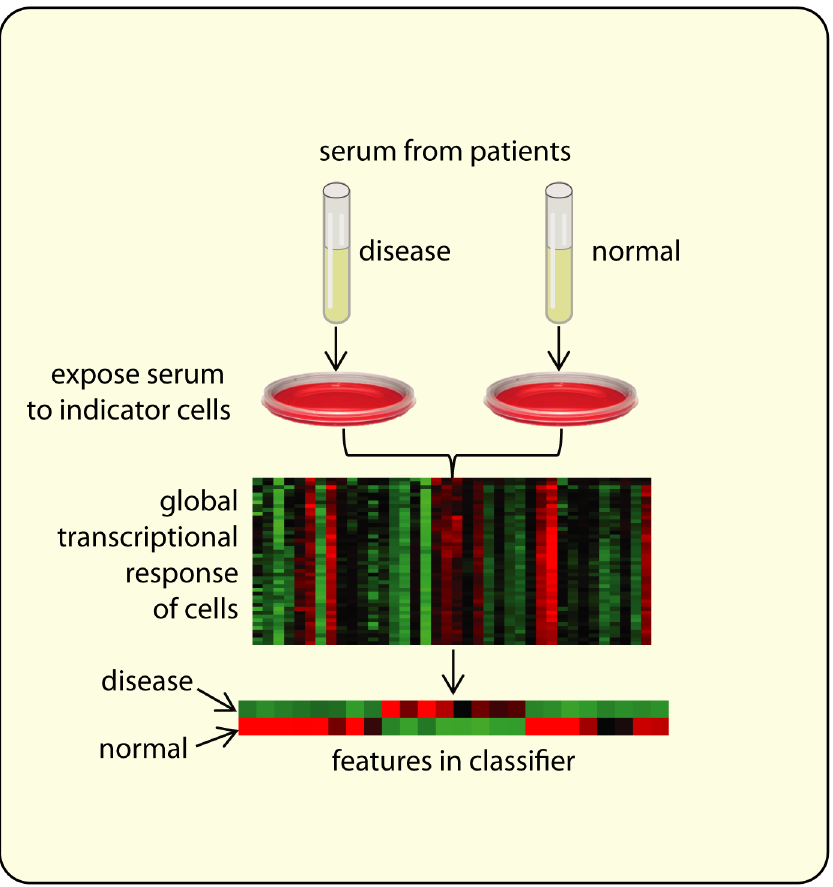
Fig 1. Development of an indicator cell assay. For each disease indication, the globaldifferential gene expressionpattern of the indicatorcells is measuredin responseto serum from normal and diseased subjects, and is used to identify a reliablediseaseclassifier using a small number of features. To deploy the assay, the cell-basedcomponents can be automatedand miniaturized,and the expressionof classifier genes can be measuredusing a targeted, cost-effective and high-throughputreadout to classify new